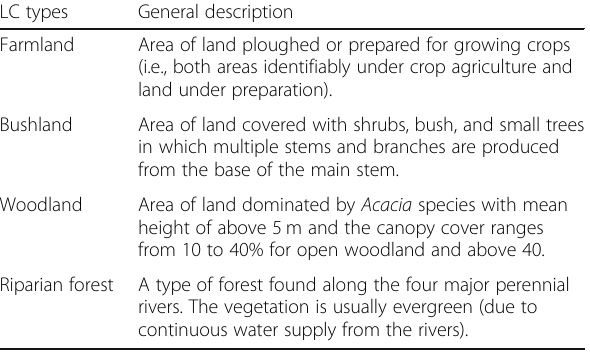
Table 1 The description of land cover (LC) types used in